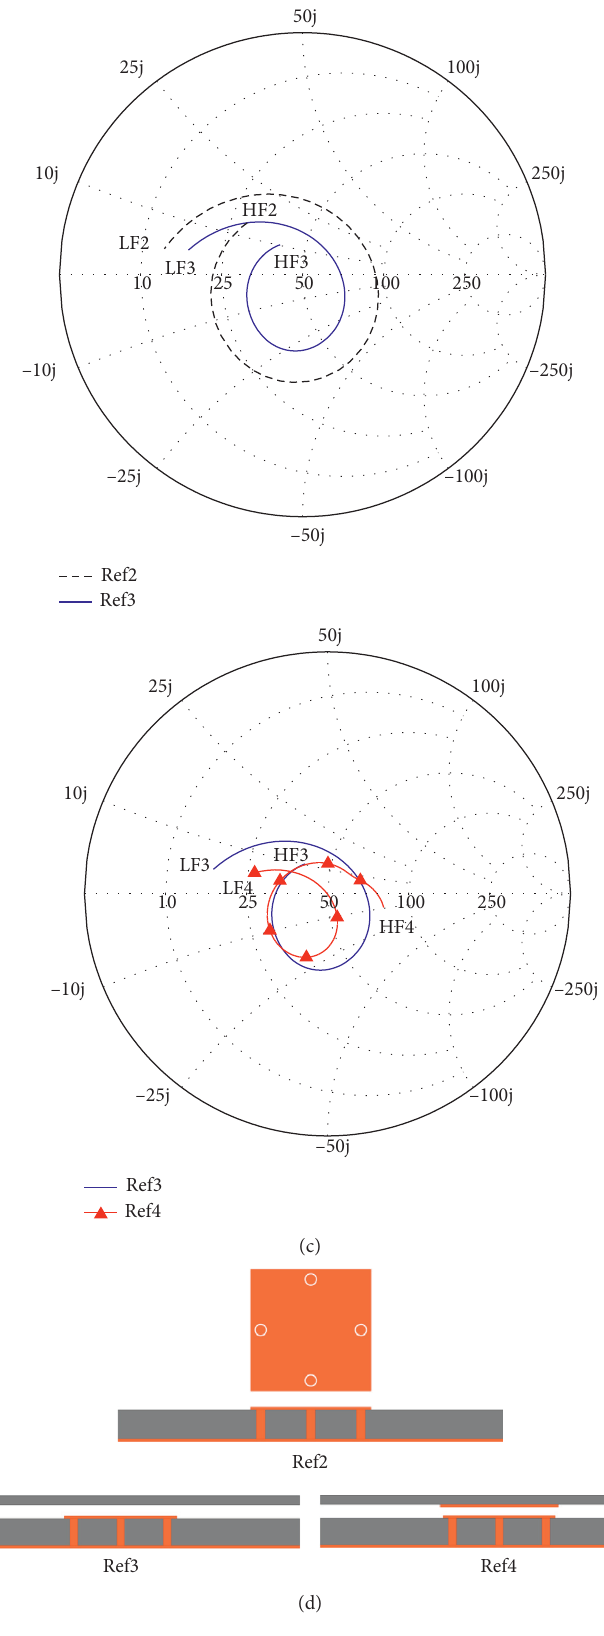
Figure 4: Simulated ( S ) ddAA , Z in , and Smith chart of different